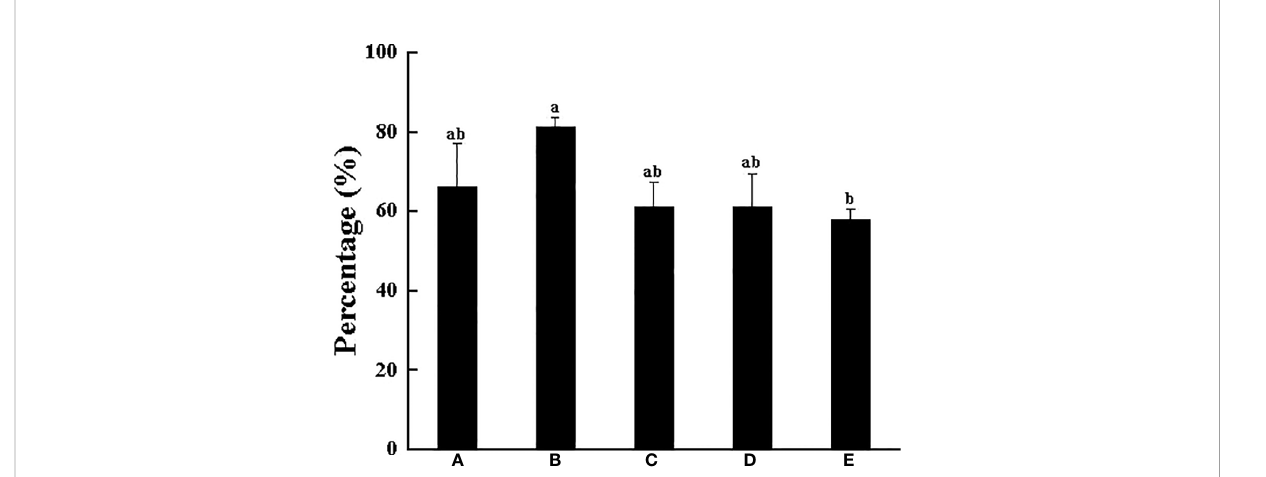
FIGURE 6 The percentage of swimming crab completing molting under the shelter with different body weight groups. Different letters indicate signi fi cant differences among different body weight groups ( P <